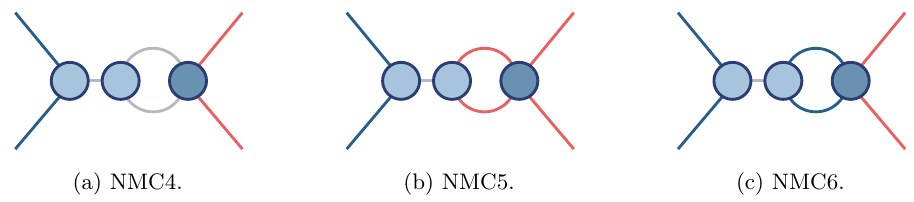
Figure 3 . Delicate next-to-maximal cuts of the one-loop four-point amplitude excluding snail and tadpole cuts. Light blue blobs represent three point amplitudes, darker blobs represent four-point amplitudes, and exposed legs represent on-shell propagators.